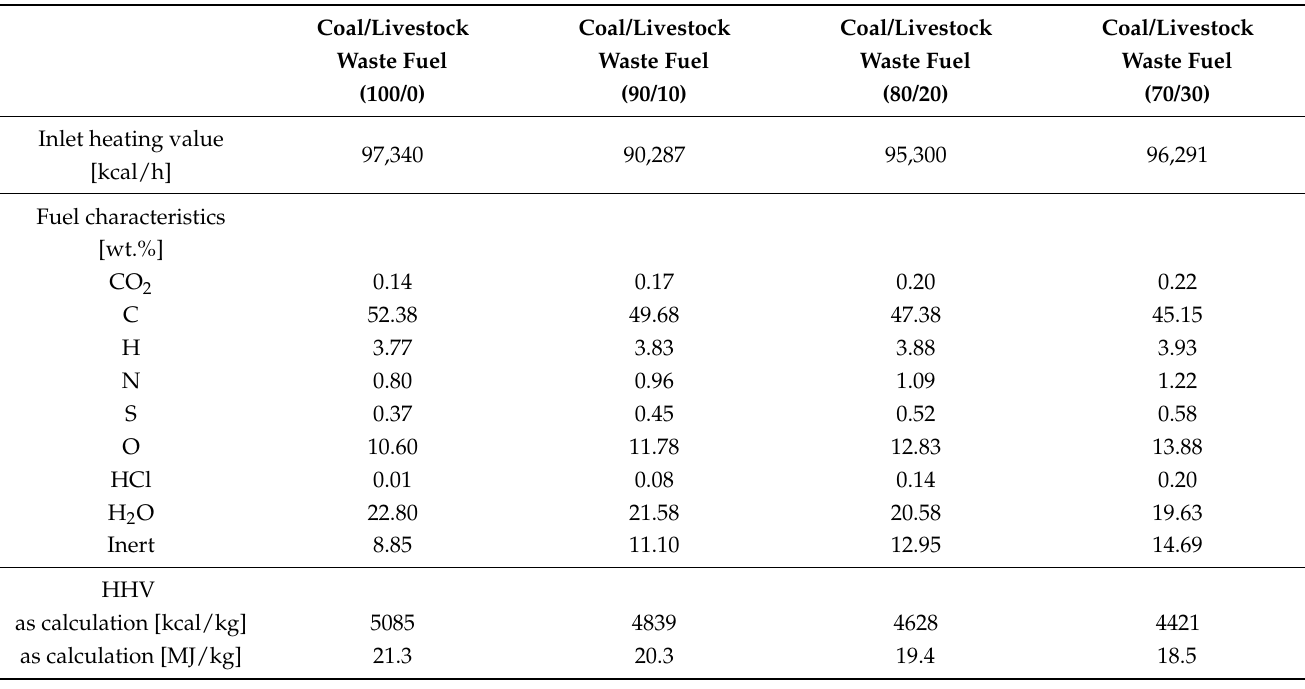
Table 2. Characteristics of blended